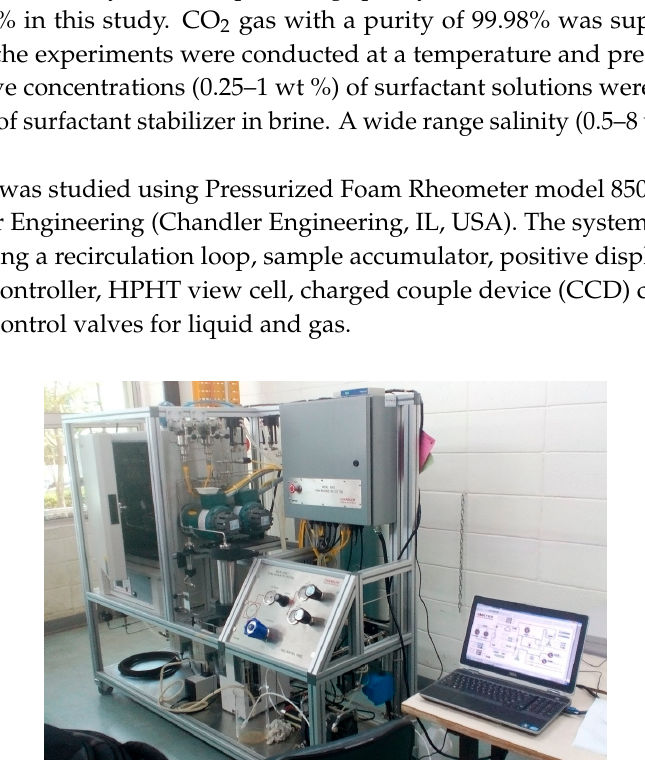
Figure 1. Pressurized foam rheometer model 8500.